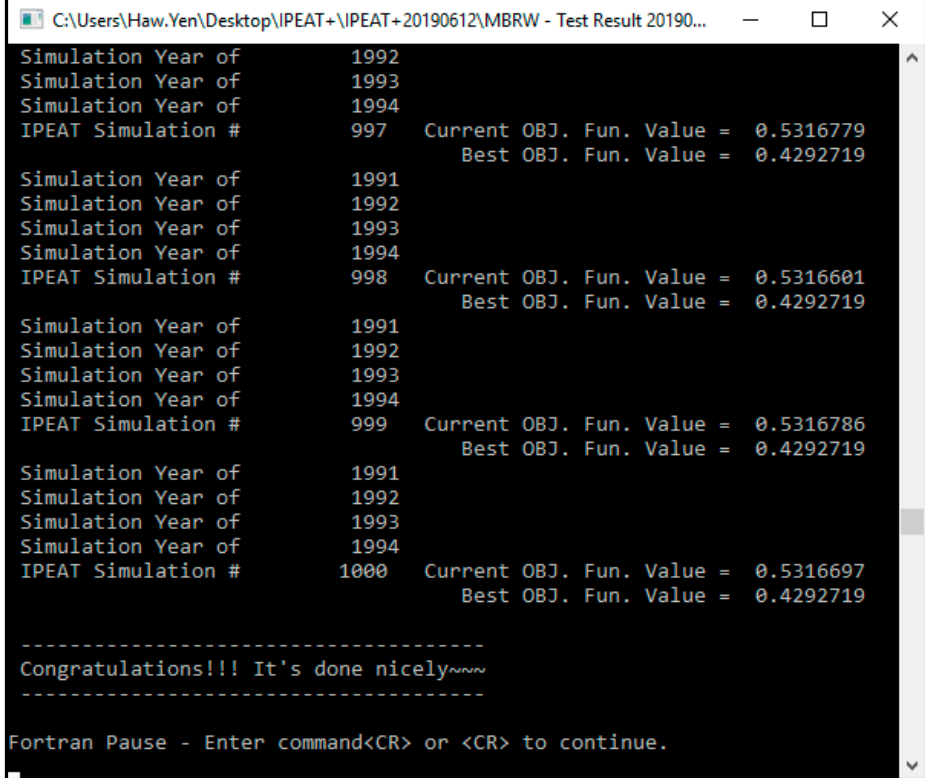
Figure 8. Convergence progression (1000 model iterations) and the corresponding values (with upper and lower bounds) of nine model parameters selected for calibration. Solid red lines represent the converged value of calibrated parameters.